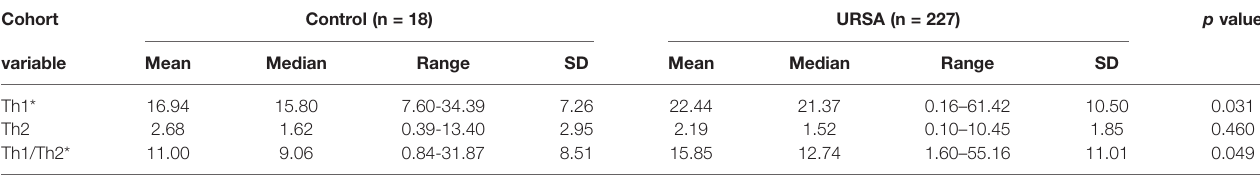
TABLE 5 | Comparison of Th1, Th2, Th1/Th2 between the case group and the control group. Cohort Control (n = 18) URSA (n = 227) variable